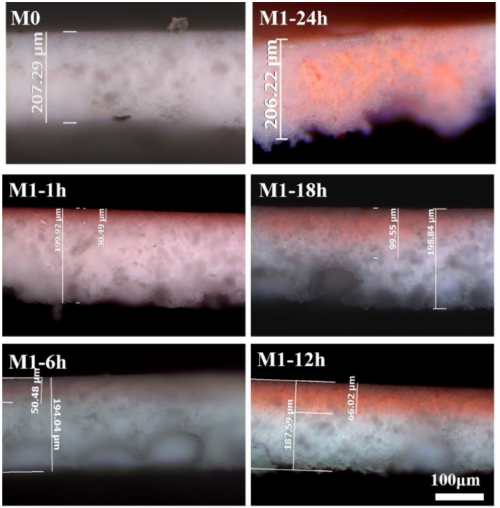
Figure 6. The controllable hydrophilic layer thickness: compared with M0, the M1 section shows a significant red layer, and its thickness increases with an increase in the thermal-crosslinking time.